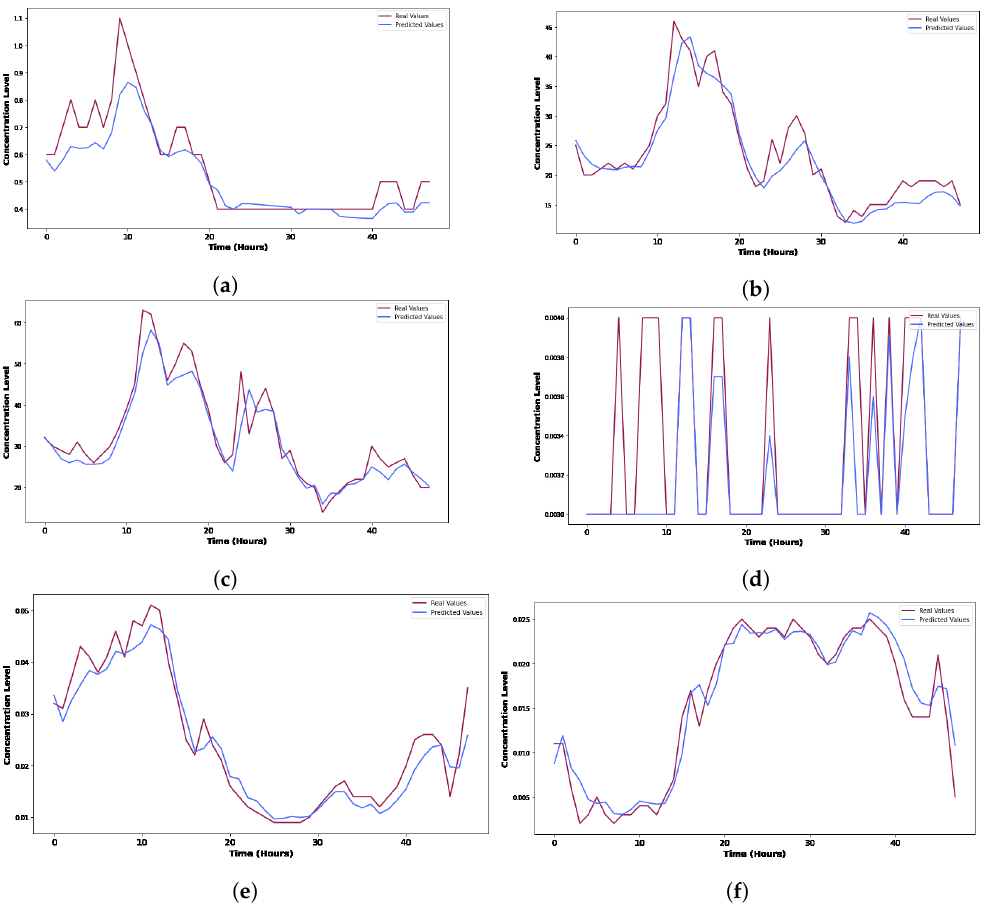
Figure 9. Comparison result of Real and Predicted air pollutant concentration of ( a ) CO , ( b ) PM 2.5 , ( c ) PM 10 , ( d ) SO 2 , ( e ) NO 2 and ( f ) O 3 .